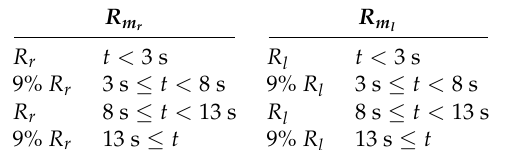
Table 2. Abrupt changes in R r and R l .